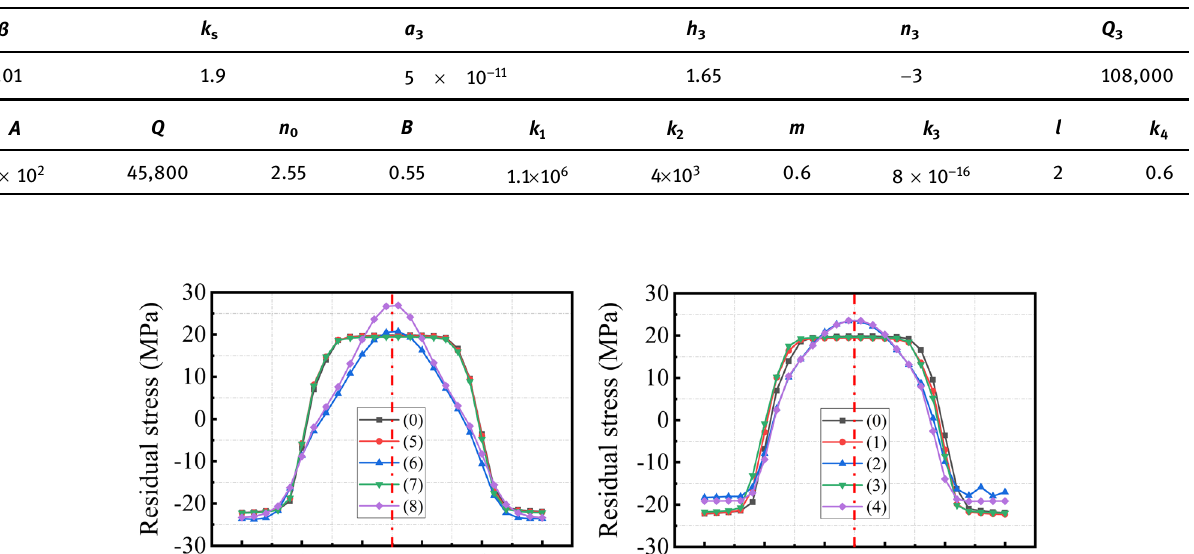
Table 5: Fitted parameters in the stress relaxation model